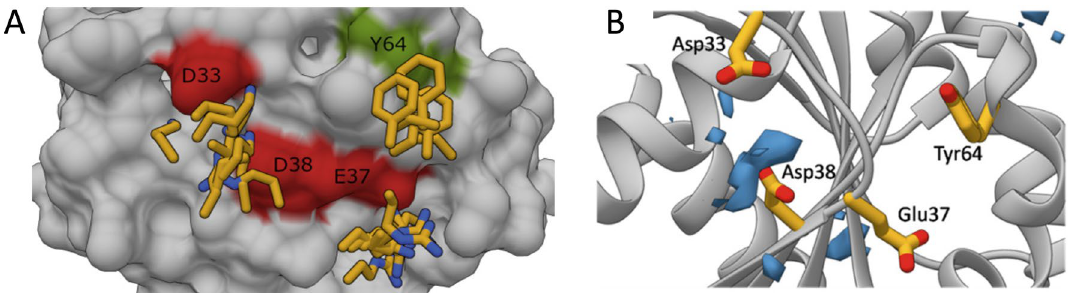
Figure 1. Peptidomimetic design. ( A ) Superimposition of eight structures of RAS GTPase in complex with effector proteins, including CRAF (PDB code 3KUD), BYR2 (PDB code 1K8R), ARAF (PDB code 2MSE), RALGDS (PDB code 1LFD), PI3K (PDB code 1HE8), PLCε (PDB code 2C5L), RASSF (PDB code 3DDC), and GRAB14 (PDB code 4K81). Highly conserved residues among RAS effector proteins are underlined with yellow bars. RAS protein surface is coloured in grey, residues involved in intermolecular contacts with highly conserved residues among effector proteins are underlined in red (Asp33, Glu37, Asp38) and green (Tyr64). ( B ) Substrate- binding site mapping on effector binding surface of RAS protein. The positively charged high propensity region between Asp33 and Asp38 is shown as a blue surface. RAS residues involved in intermolecular contact with highly conserved effector protein residues are underlined with yellow bars (Asp33, Glu37, Asp38 and Tyr64). Images were drawn using the docking program indicated in